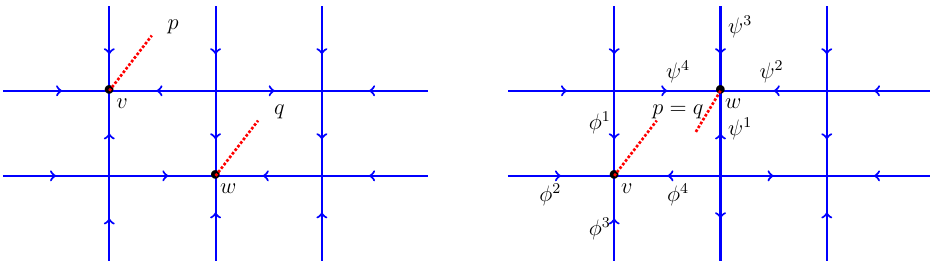
Figure 4 . Diagrams showing two different graphs each with vertices v and w which do not